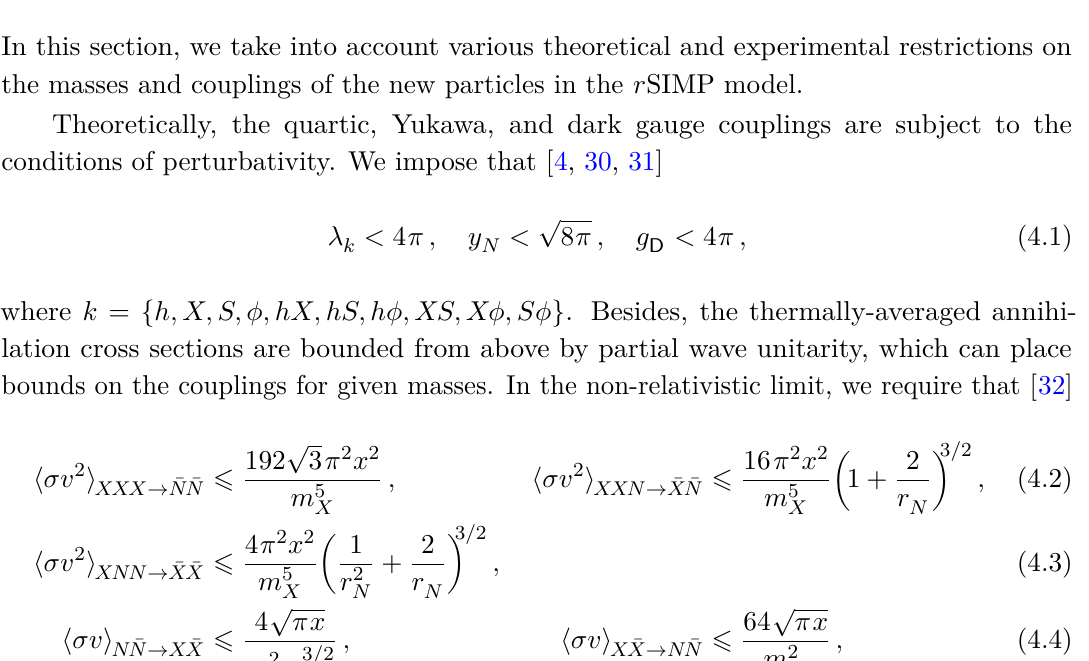
Figure 3 . The two-loop functions I the resonance. As indicated, the I